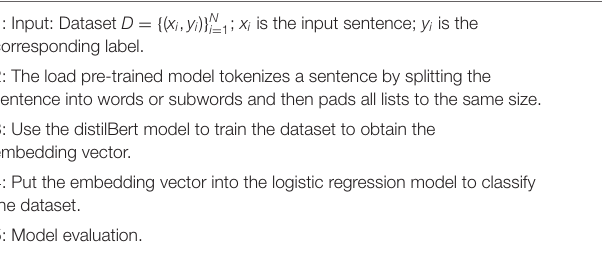
Algorithm 1 | The process of our algorithm